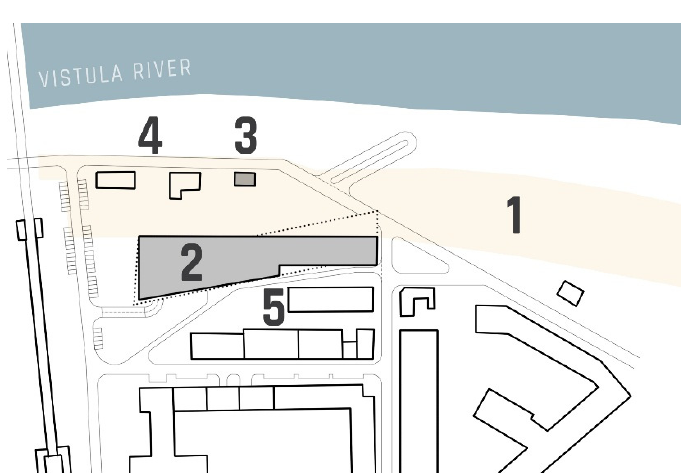
Figure 20. Embedding the object in the context: (1) Flood risk area, (2) Designed multifunctional complex, (3) Designed sports equipment rental, (4) Existing historic buildings, (5) Existing objects of the lighting company (elaborated by E. Latusek).